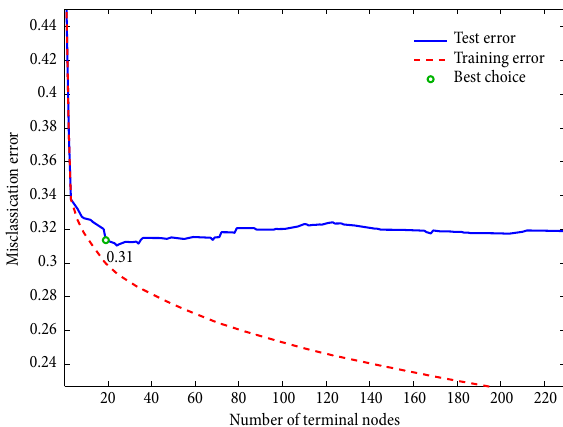
Fig. 1. Relationship between tree complexity (number of terminal nodes) and error rate on training set and testing set